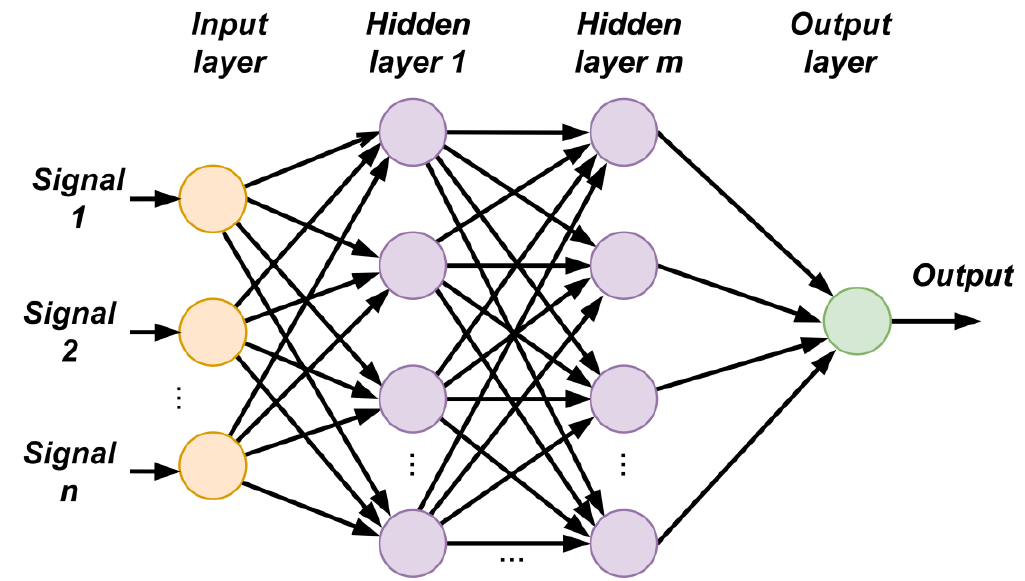
Figure 2. Topology of a neural network with n inputs, m hidden layers, and individual output.